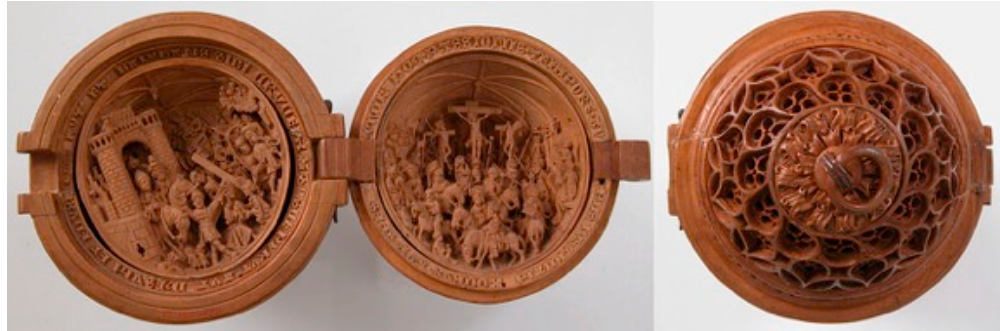
Figure 8. The interior ( left ) and exterior ( right ) of a 16th-century prayer nut (Image courtesy of the Metropolitan Museum of Art).